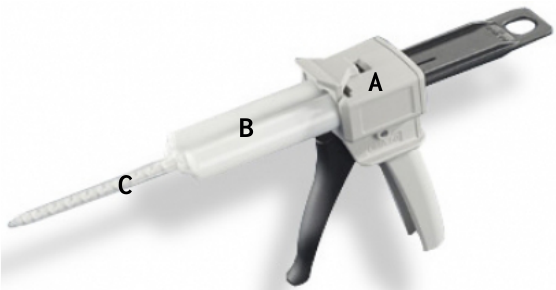
Figure 3. Depiction of wound closure strength test specimen.